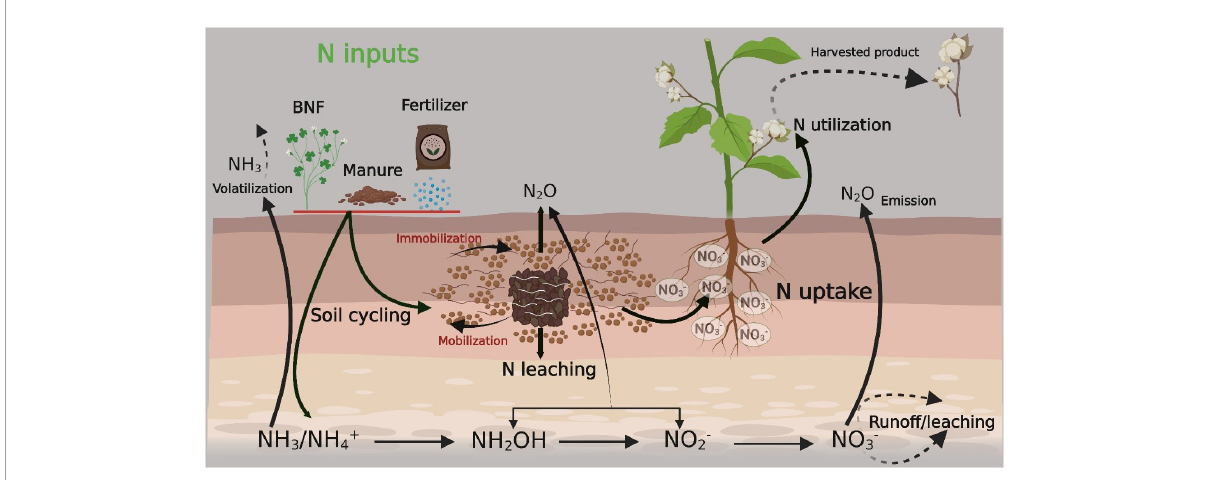
FIGURE1 Summary of nitrogen sources and their conversion, availability to plant along with final harvested product and losses within/outside of soil. The figure created with Biorender (https://biorender.com/). BNF, biological nitrogen